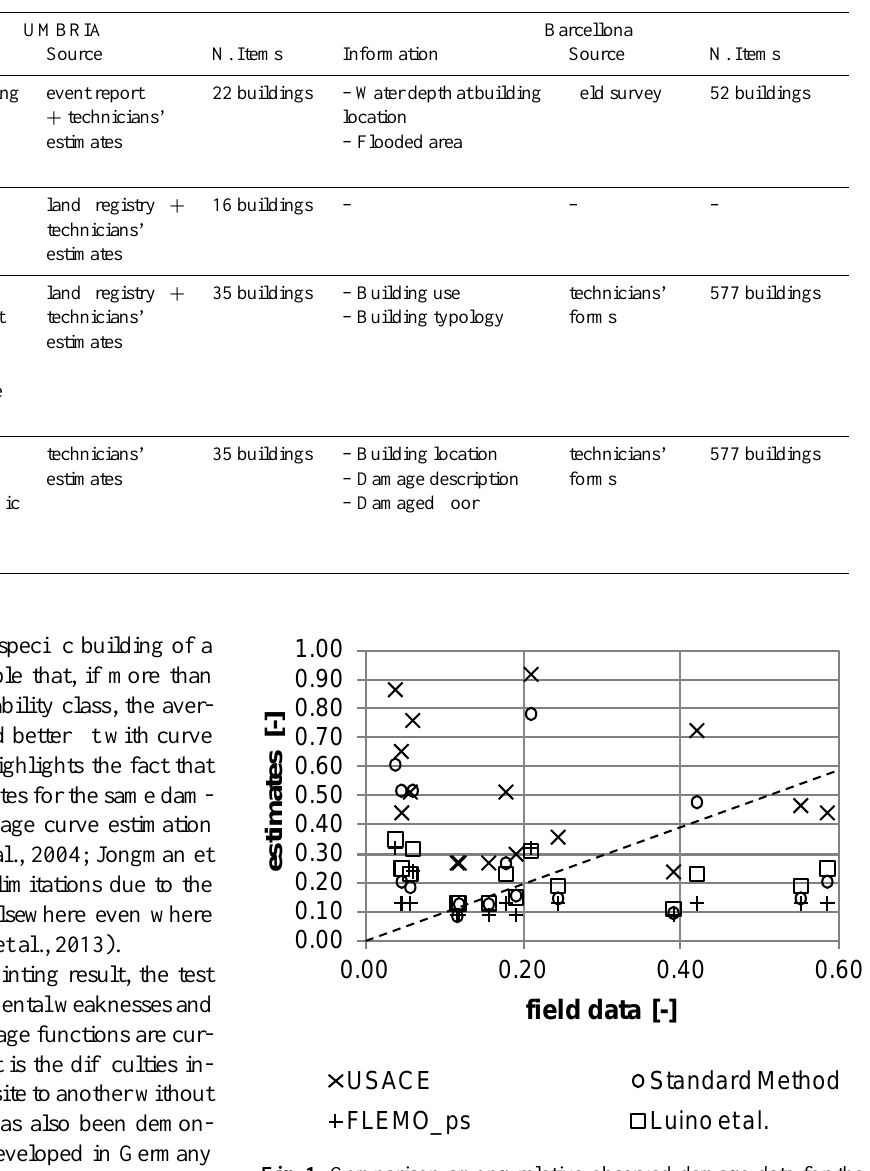
Fig. 1. Comparison among relative observed damage data for the Umbria case study (i.e. field data) and estimates supplied by existing depth-damage curves.